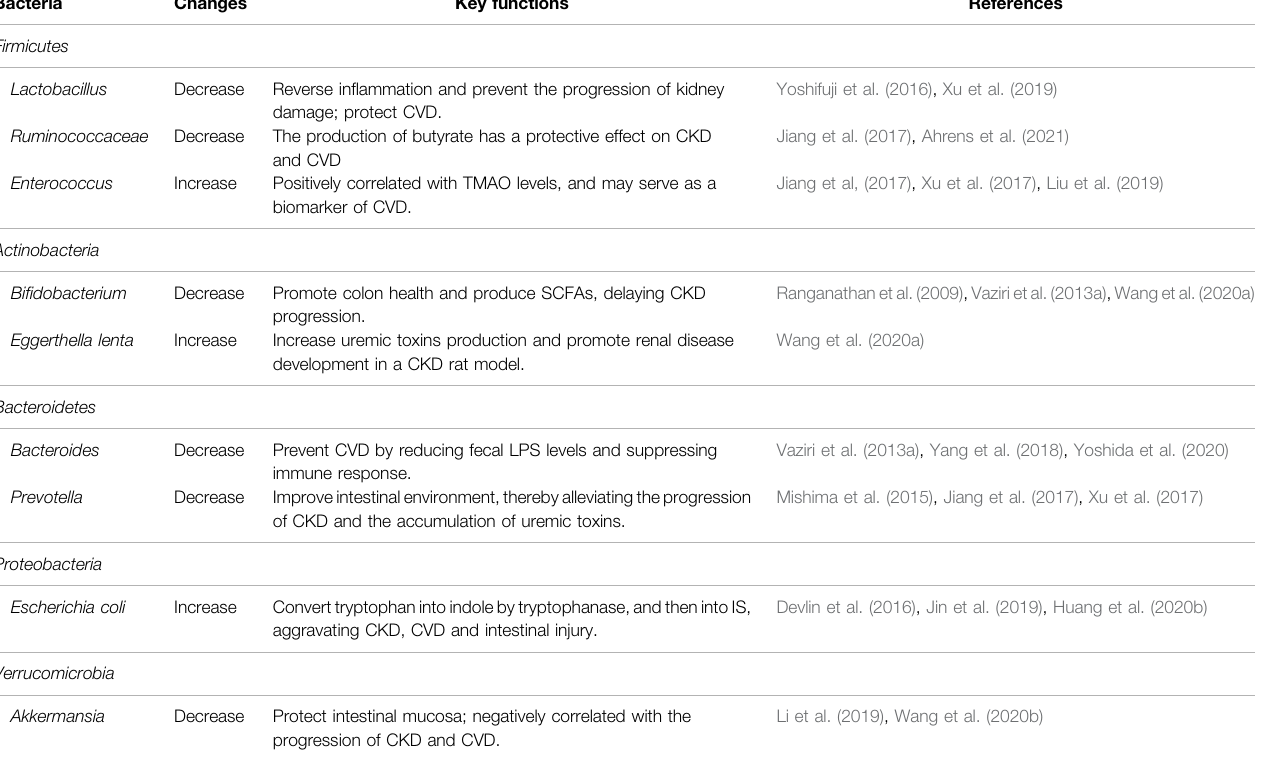
TABLE 1 | The changes and functions of gut microbiota in CKD